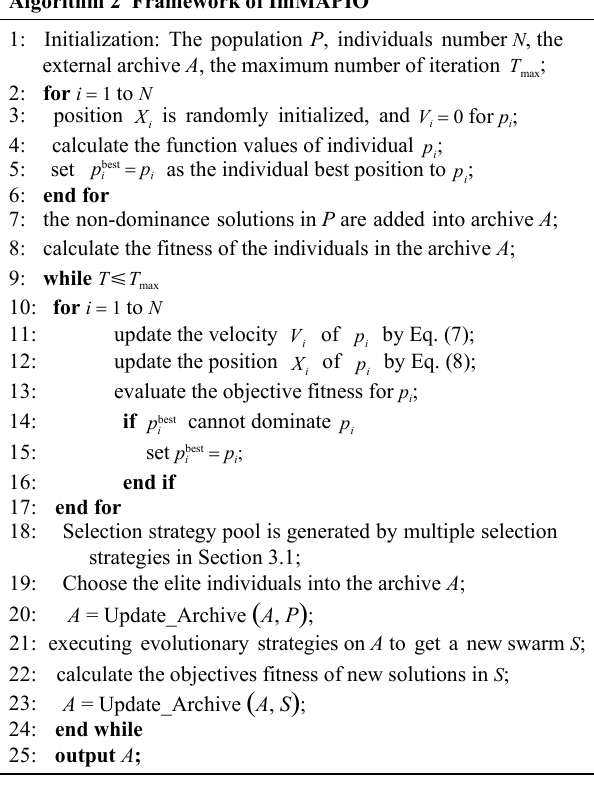
Algorithm 2 Framework of